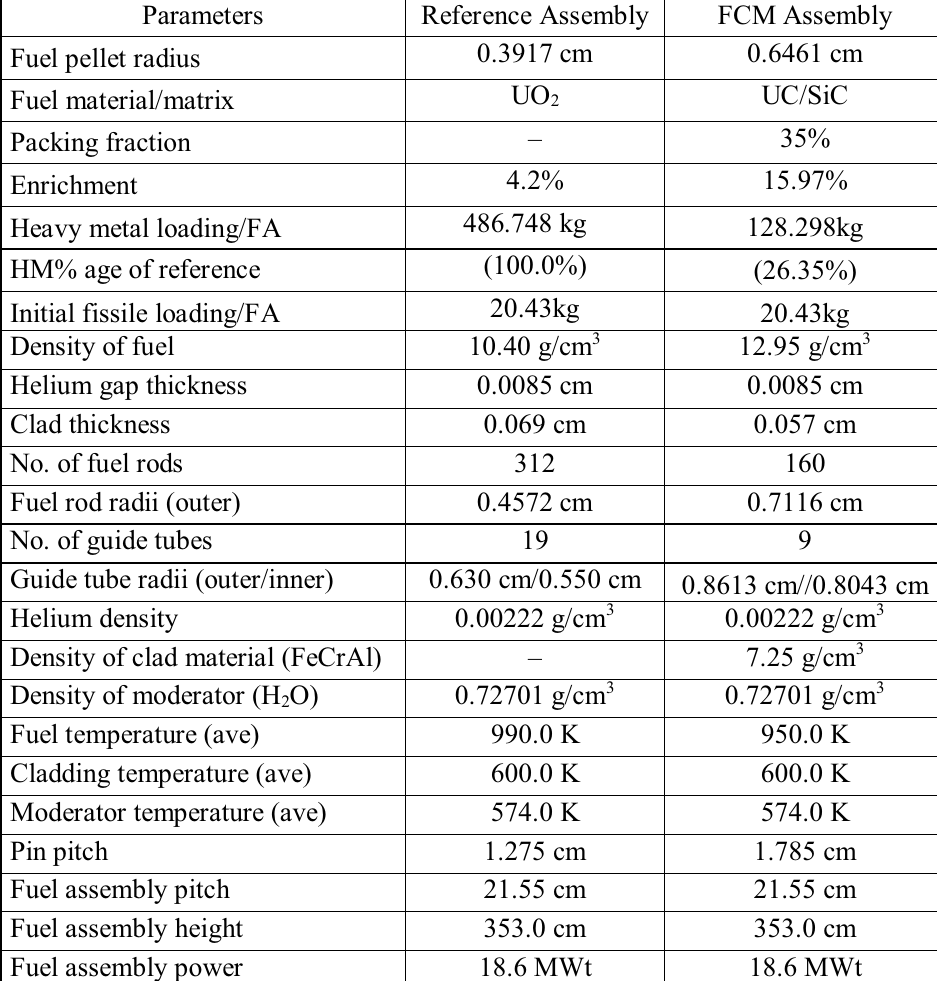
Table I. Description of the Assembly parameters.